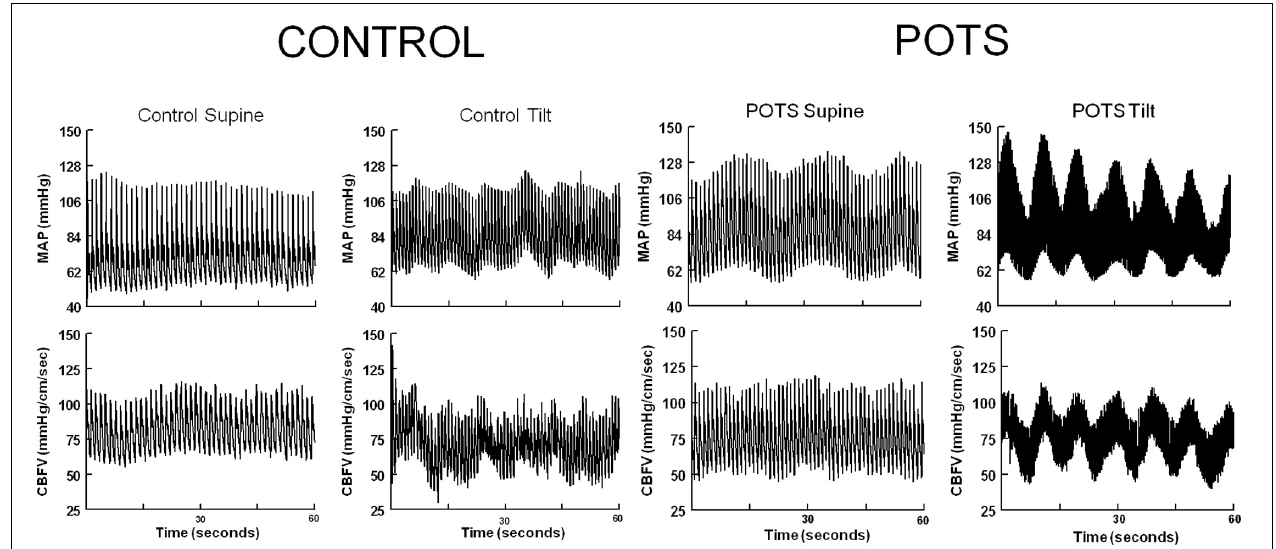
FIGURE 1 | Representative supine and upright control and POTS phasic arterial pressure (AP) and cerebral blood flow velocity (CBFv) in the time domain. With tilt, oscillations in arterial pressure